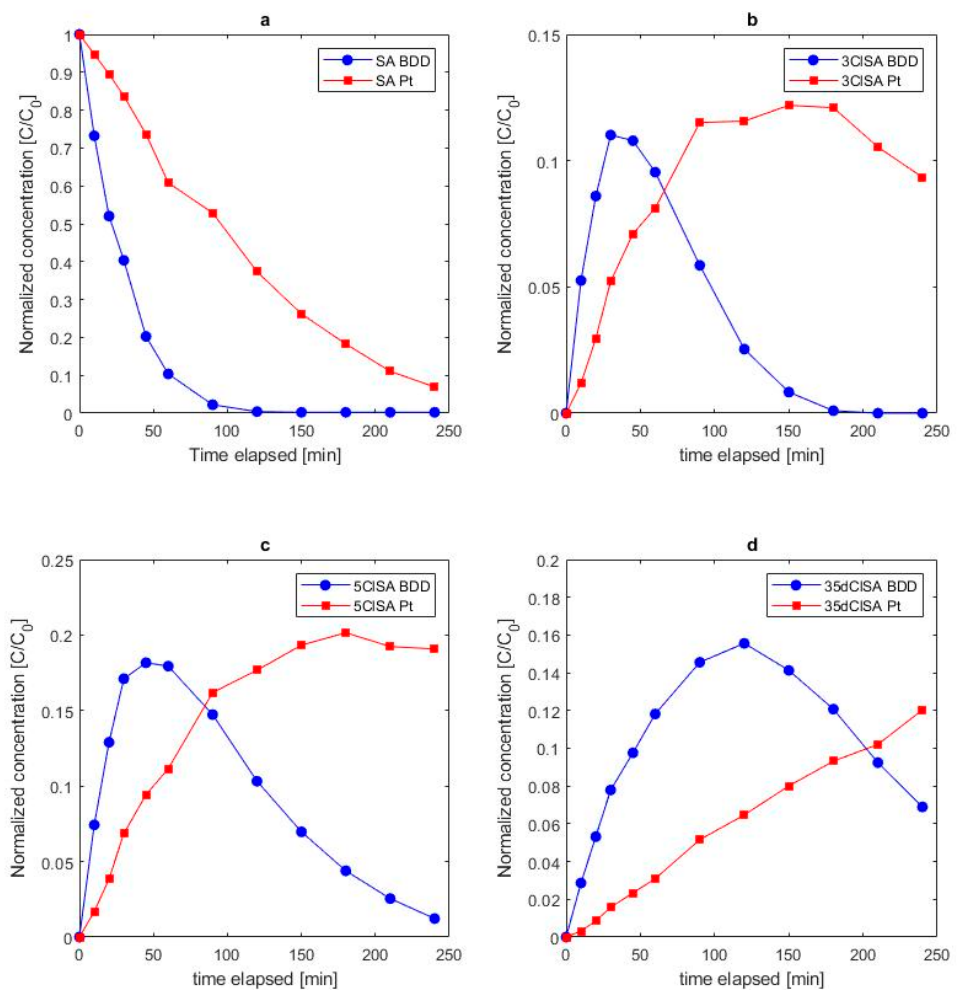
Figure 7. Normalized concentration profiles with respect to initial molar SA concentration [C0]: SA ( a ) chlorinated degradation products ( b – d ) on BDD and Pt electrodes .